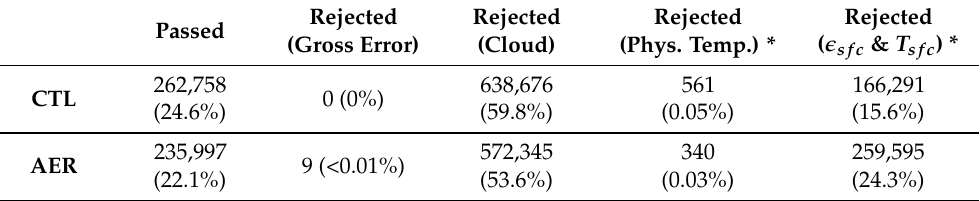
Figure 8. Same as Figure 7, but for bias estimates differences (AER minus CTL) from the predictors of ( a ) lapse rate term and ( b ) emissivity term. Stippling indicates the difference is 99% significant ( p ≤ 0.01). Table 2. The count of observations categorized by QC checks at 10.39 µm of IASI onboard MetOp-A from CTL (top row) to AER (bottom row) during 1–28 August 2017. The total number of observations is